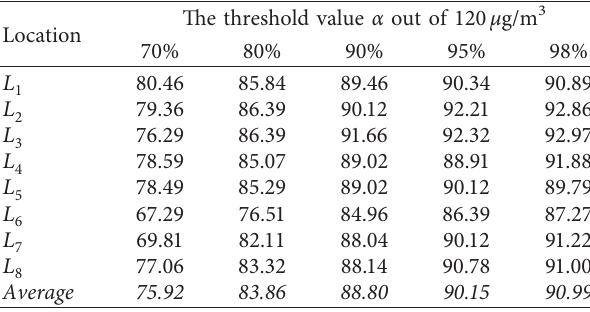
Table 9: The accuracy ratio of the haze warning system by Algorithm